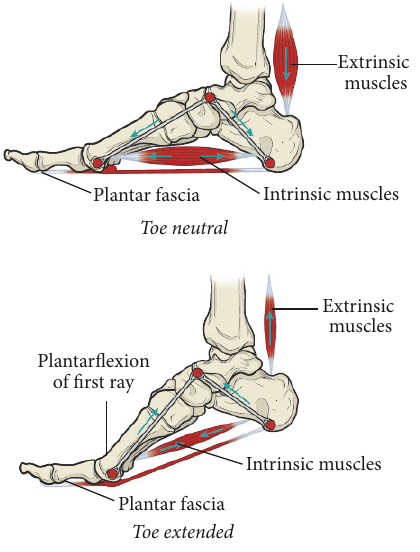
Figure 2: Windlass mechanism [45].